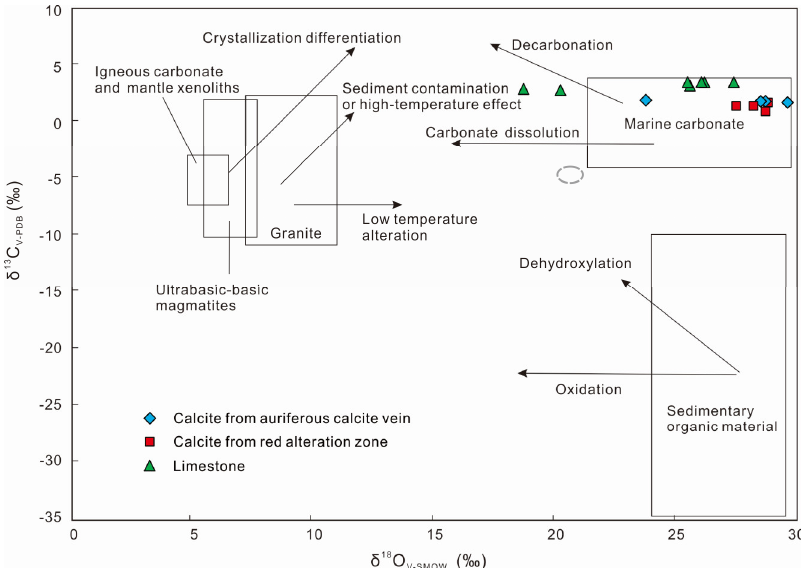
Figure 8. The δ 13 C V-PDB and δ 18 O V-SMOW values of calcite from the Phapon gold deposit. The area in grey dashed line shows δ 13 C V-PDB –δ 18 O V-SMOW values of hydrothermal calcite from Phapon [15]. References for the fields of major carbon reservoirs and other deposits are from [68].